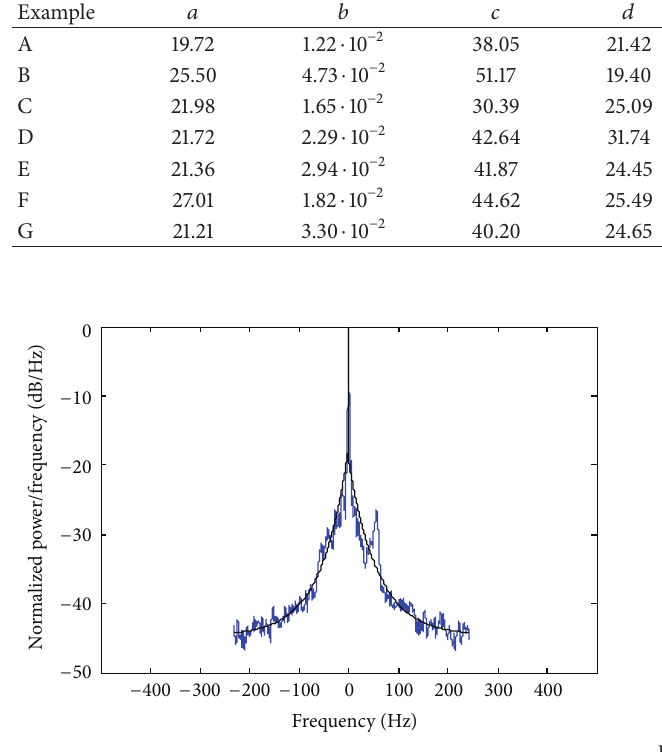
Figure 14: Example F: estimated PSD and corresponding exponen- tial fitting ( 𝑎 = 27.01 , 𝑏 = 1.82 ⋅ 10 −2 , 𝑐 = 44.62 , 𝑑 = 25.49 , 𝑒 = 1.71 ⋅ 10 −2 , 𝑔 = 44.58 , 󳵻𝑓 = 473.87 , and 𝛾 = 0.03 ).